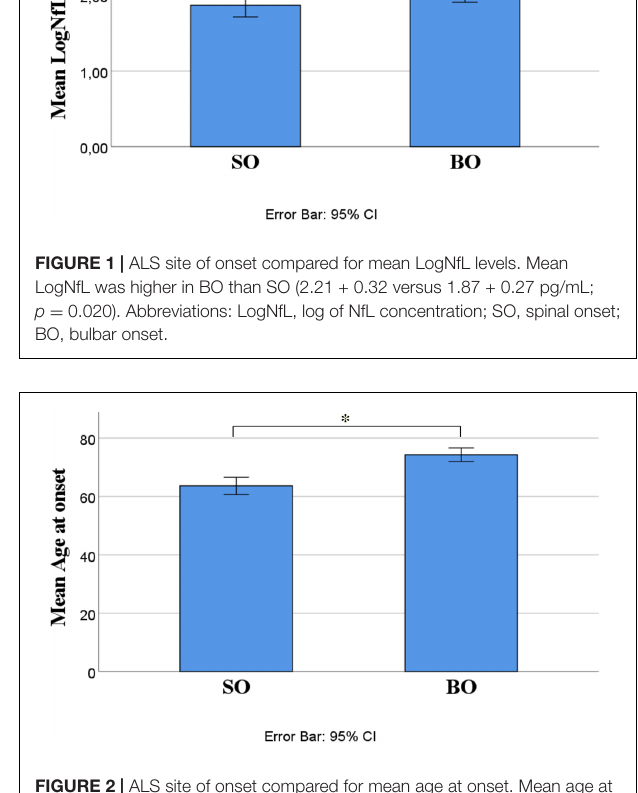
FIGURE 2 | ALS site of onset compared for mean age at onset. Mean age at onset was higher in BO than SO (62 + 4.33 versus 76.86 + 1.74. p = 0.006). Abbreviations: LogNfL, log of NfL concentration; SO, spinal onset; BO, bulbar